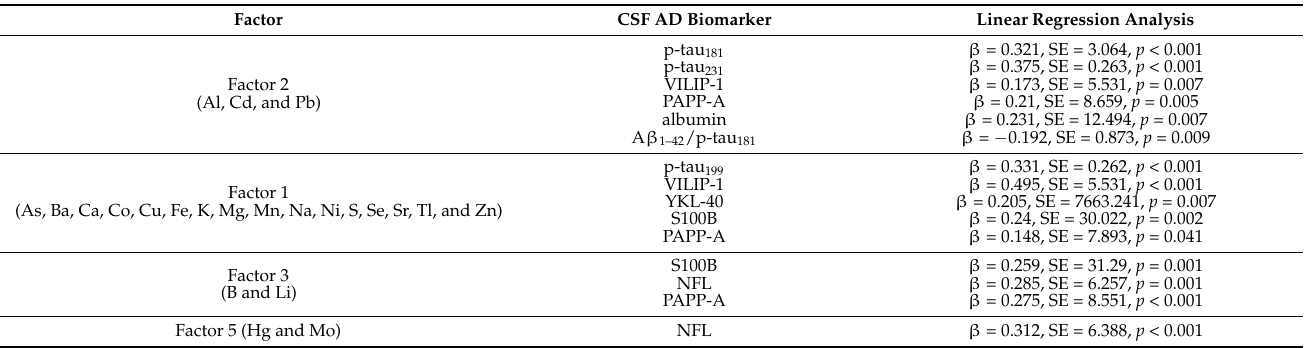
Table 4. Results of linear regression analysis; comparison of factors obtained by PCA of CSF macro- and microelements with CSF AD